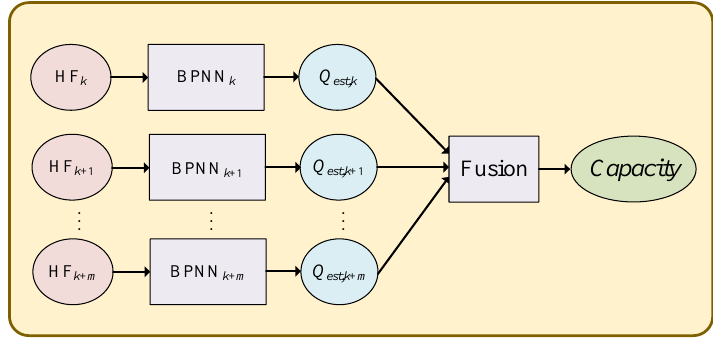
Figure 16. Fusion of the multiple estimated capacity results.